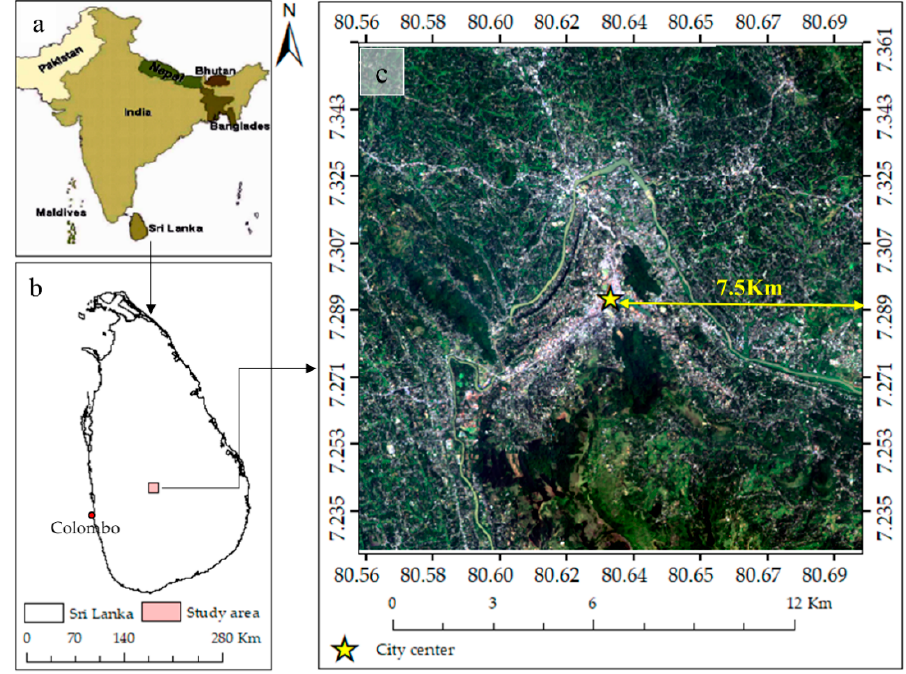
Figure 1. Study area. ( a ) South Asia; ( b ) Sri Lanka; and ( c ) study area represented with a Landsat-8 image in true color composite (bands 4, 3, 2; 18 March 2017).